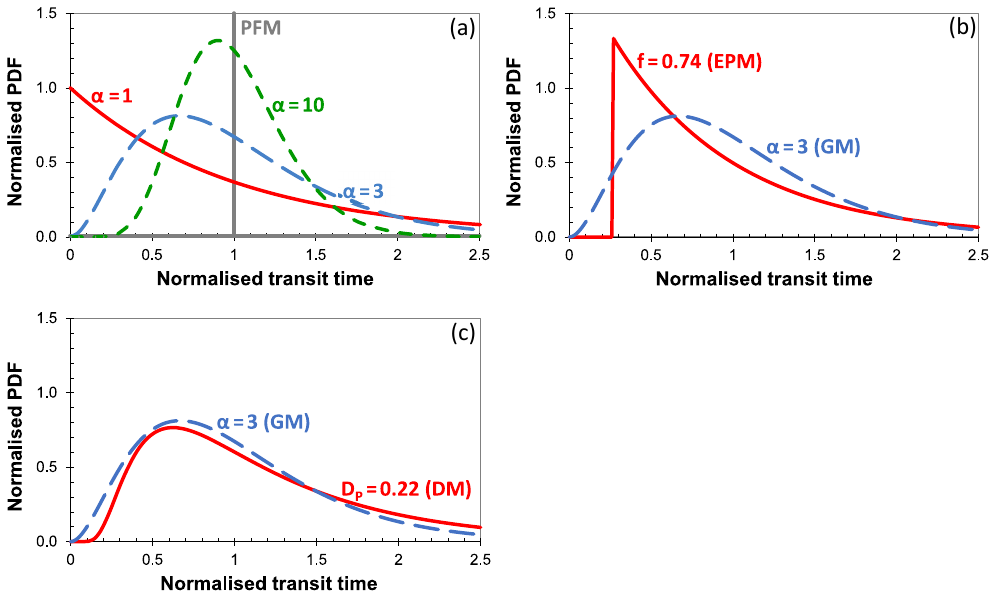
Figure 2. (a) Gamma model (GM) distributions for shape factors α between 1 and 10. The axes show normalised transit time ( τ/τ m ) and normalised probability density function (PDF) ( h(τ) × τ m ) . Note that the distribution for GM ( α = 1) is the same as that for the exponential model (EM). (b, c) Comparison between the GM with α = 3 and the best-fitting exponential piston flow and dispersion